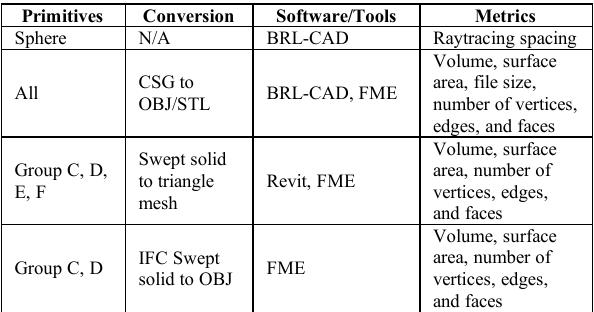
Table 1 . Summary of primitives, conversion, and